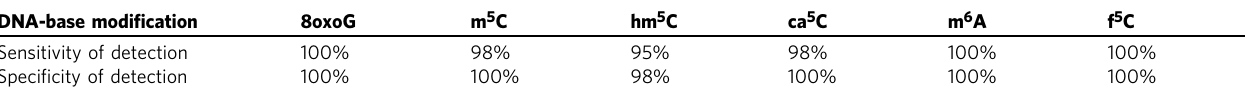
Table 1 Sensitivity and speci fi city of DNA base detection with MTs using our antibody-based approach. DNA-base modi fi